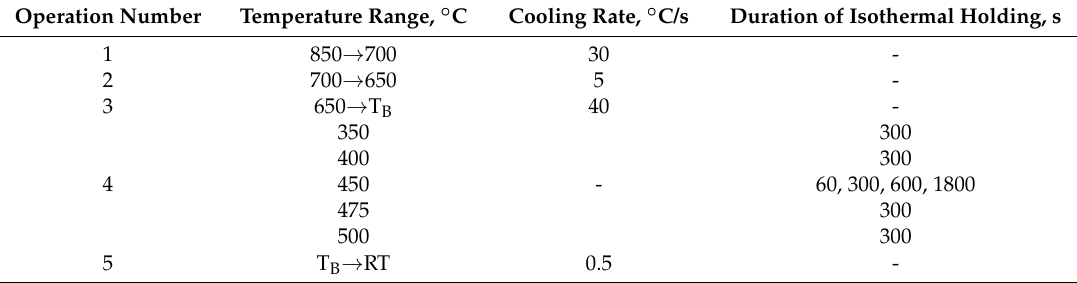
Figure 1. Thermomechanical processing conditions of investigated steels (for specimens isothermally held at 400 °C). Table 2. Parameters of cooling after deformation for 3Mn and 3MnNb steels.